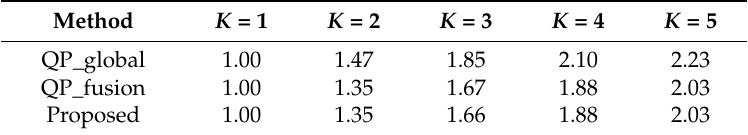
Table 4. Average rank of TV recommender systems with external user information.